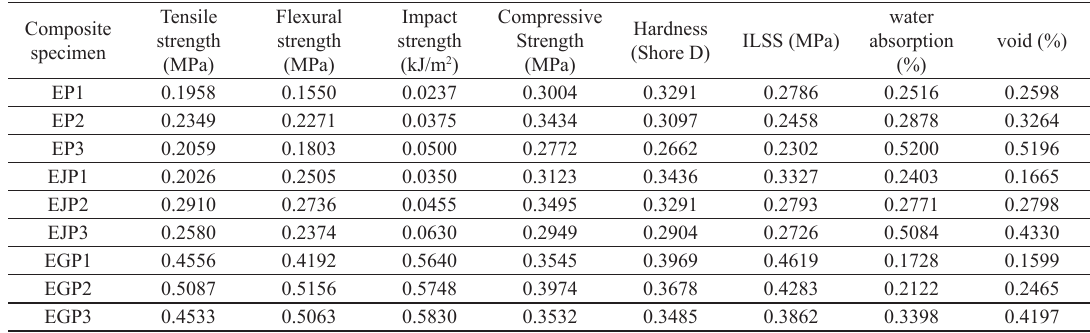
Table 5. Normalized decision